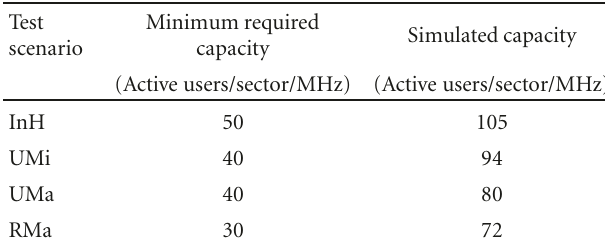
Table 5: VoIP capacity requirement in IMT-Advanced and simu- lated